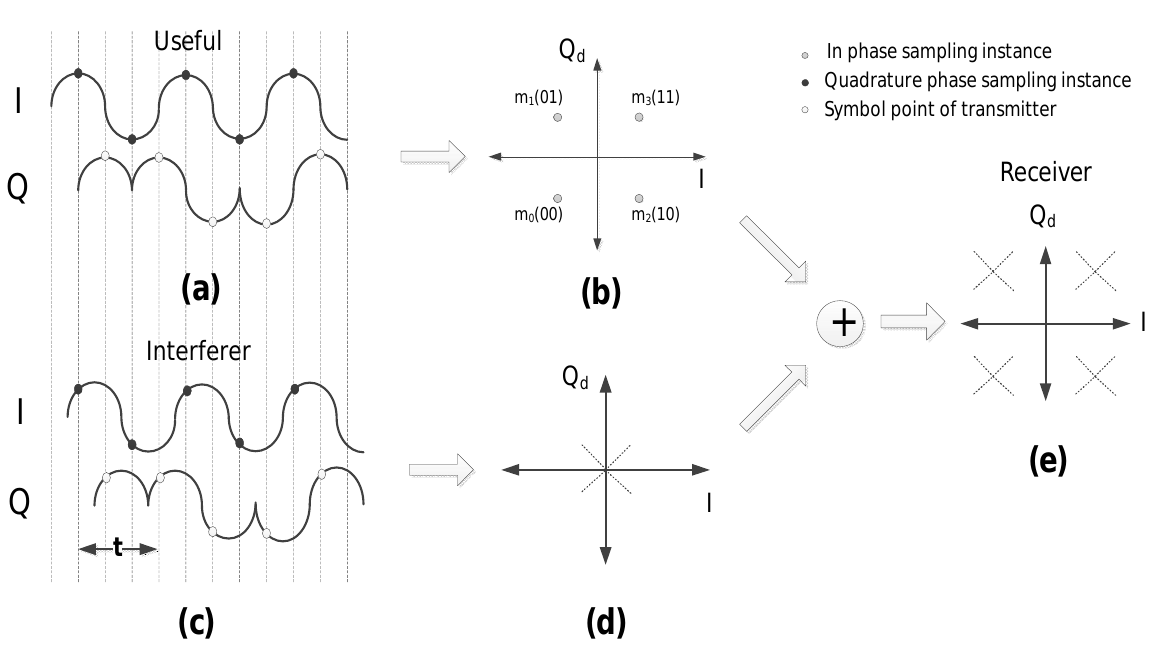
-I d -I domain representation d